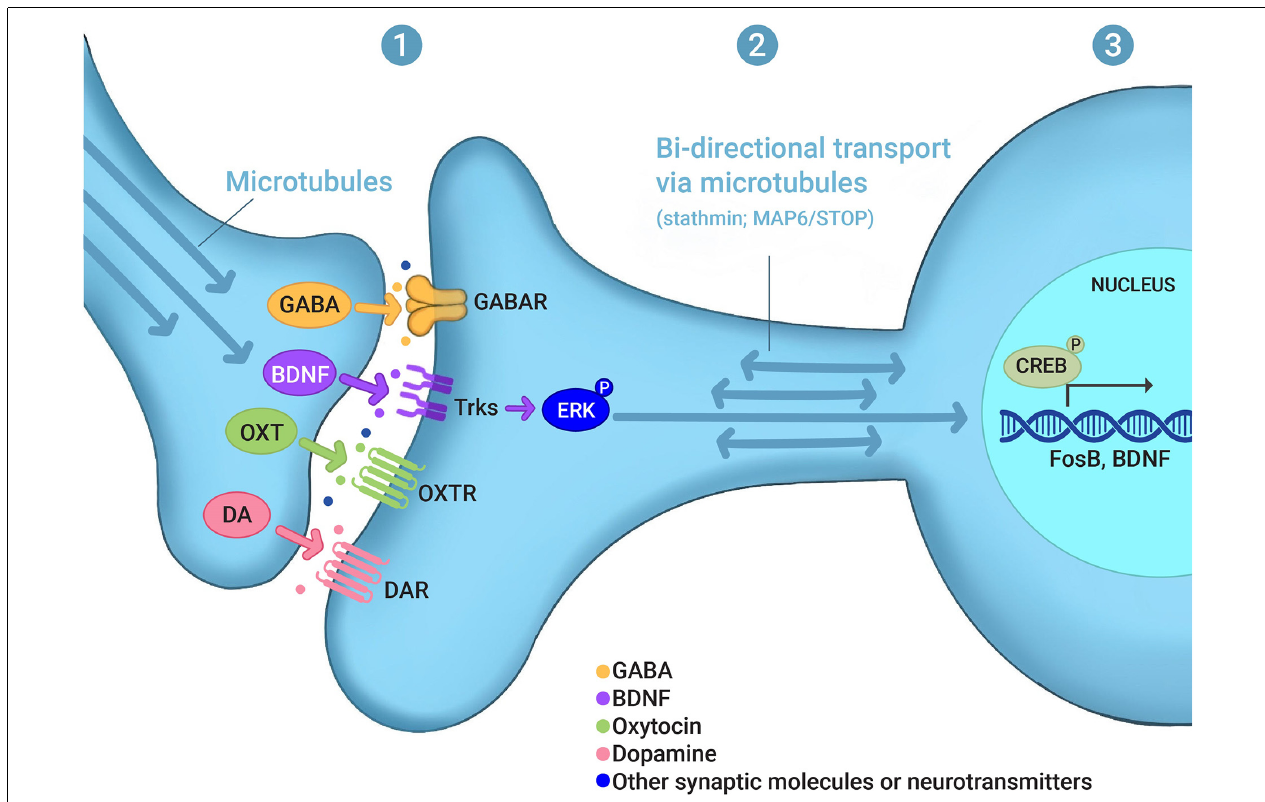
FIGURE 1 | Experience-dependent signaling in maternal behaviors. Evidence discussed in this review indicates that experience- or activity-dependent signaling may occur (1) at synapses, affecting the localization of pre- and postsynaptic receptors and other synaptic proteins as well as changes in the post-translational modifications of synaptic proteins, such as GABA, BDNF, oxytocin (OXT), and dopamine (DA); (2) at the level of the bidirectional transport between synapses and the nucleus, which involves microtubule and microtubule-regulating proteins, such as stathmin and MAP6/STOP; and (3) at the level of gene transcription in the nucleus, which involves, for example, CREB as a transcription factor and FosB and BDNF as gene targets. (P) in ERK-P and CREB-P denotes protein phosphorylation. For other abbreviations see the main